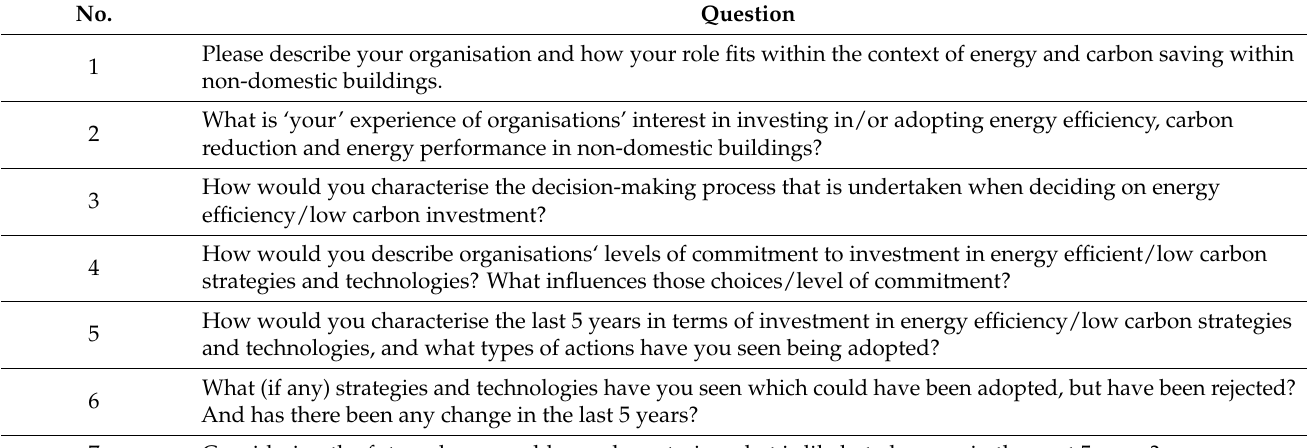
Table 2. Interview questions.